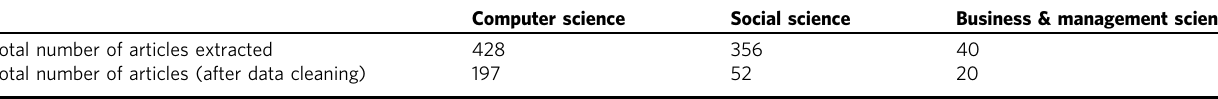
Table 1 Descriptive results of the bibliometric literature review.